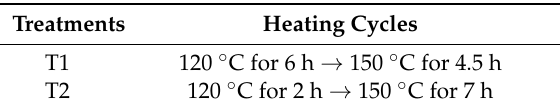
Table 1. Heating cycles of furfuryl alcohol (FA)